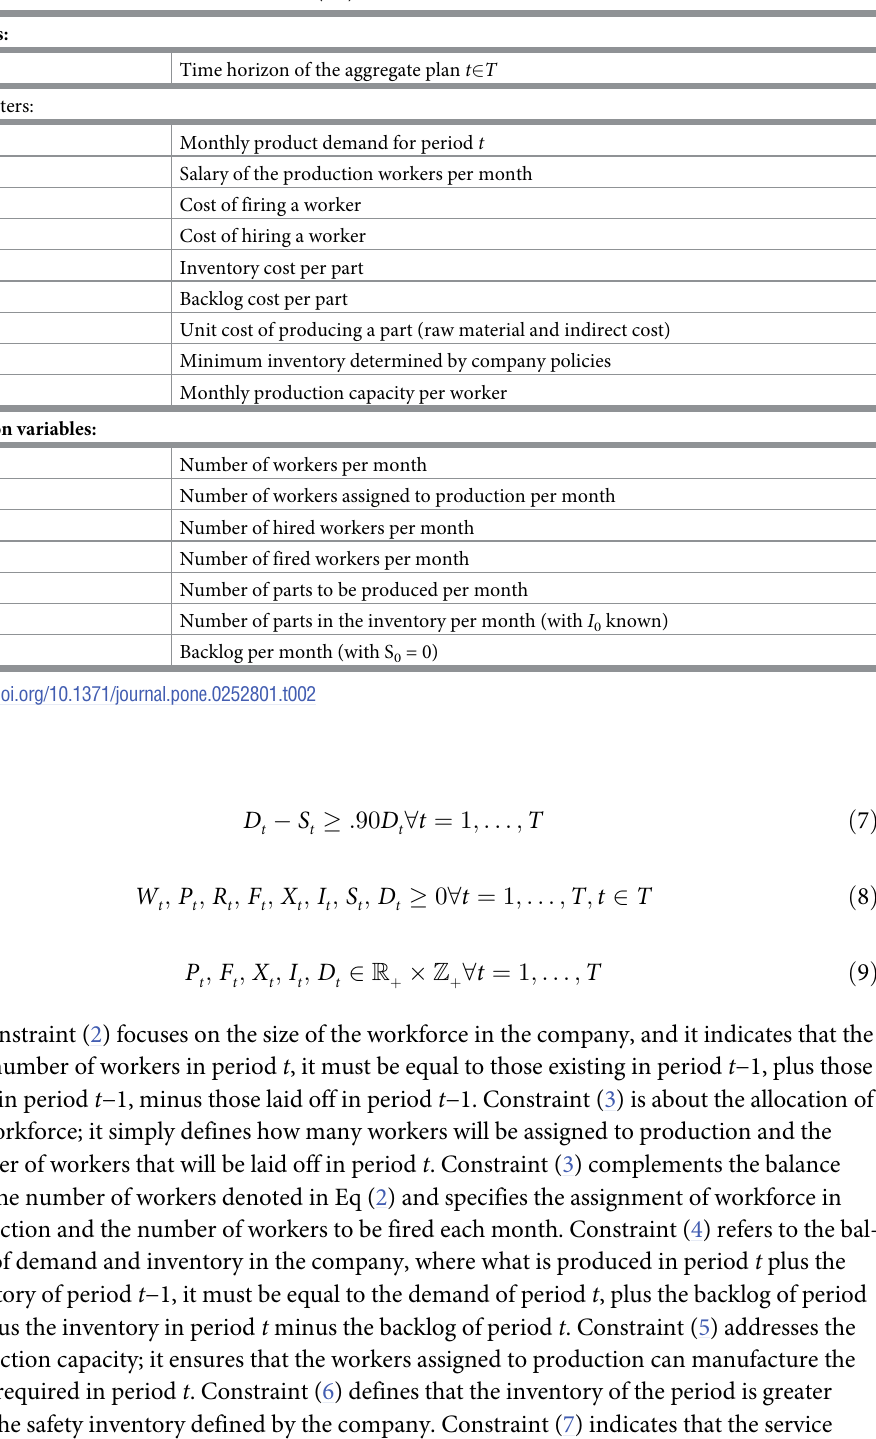
Table 2. Notation of the deterministic model